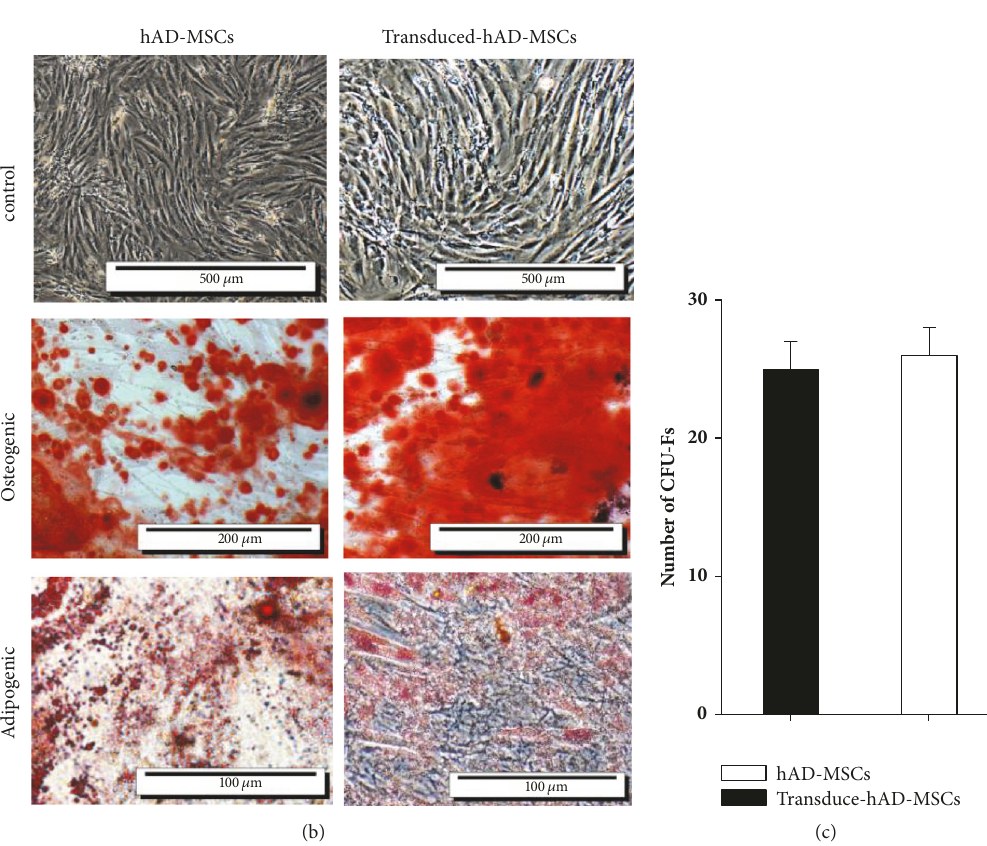
Figure 5: The mesenchymalstem cells (MSCs) characterizationby flow cytometry, differentiation, and CFU-Fassay. (a) Expression of surface antigens in hAD-MSCs, and transduced hAD-MSCs as determined using flow cytometry. (b) Control: the second passage of hAD- MSCs and transduced hAD-MSCs. Osteogenic: staining of hAD-MSCs and transduced hAD-MSCs by Alizarin Red S reagent; calcium deposits stained brightorange-redaroundhAD-MSCsdifferentiatedintoosteocytesonthe21thday.Adipogenic:stainingofhAD-MSCsandtransducedhAD- MSCs after 2nd passage by Oil Red O reagent;intracellularvesicles of oil accumulatedand stained bright red within hAD-MSCsdifferentiated into adipocytes on the 21th day. (c) Clonogenic capacity was measured by colony forming unit-fibroblast (CFU-F) assay. The results are represented as the means ± SD.